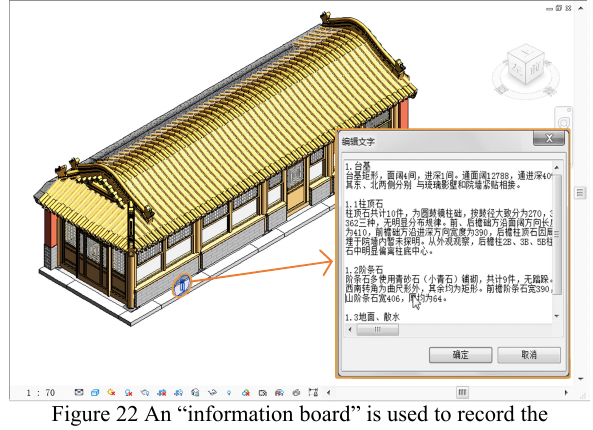
Figure 22 An “information board” is used to record the information of the whole platform 3.2.2 Informatization of 2D drawings : in this case, window